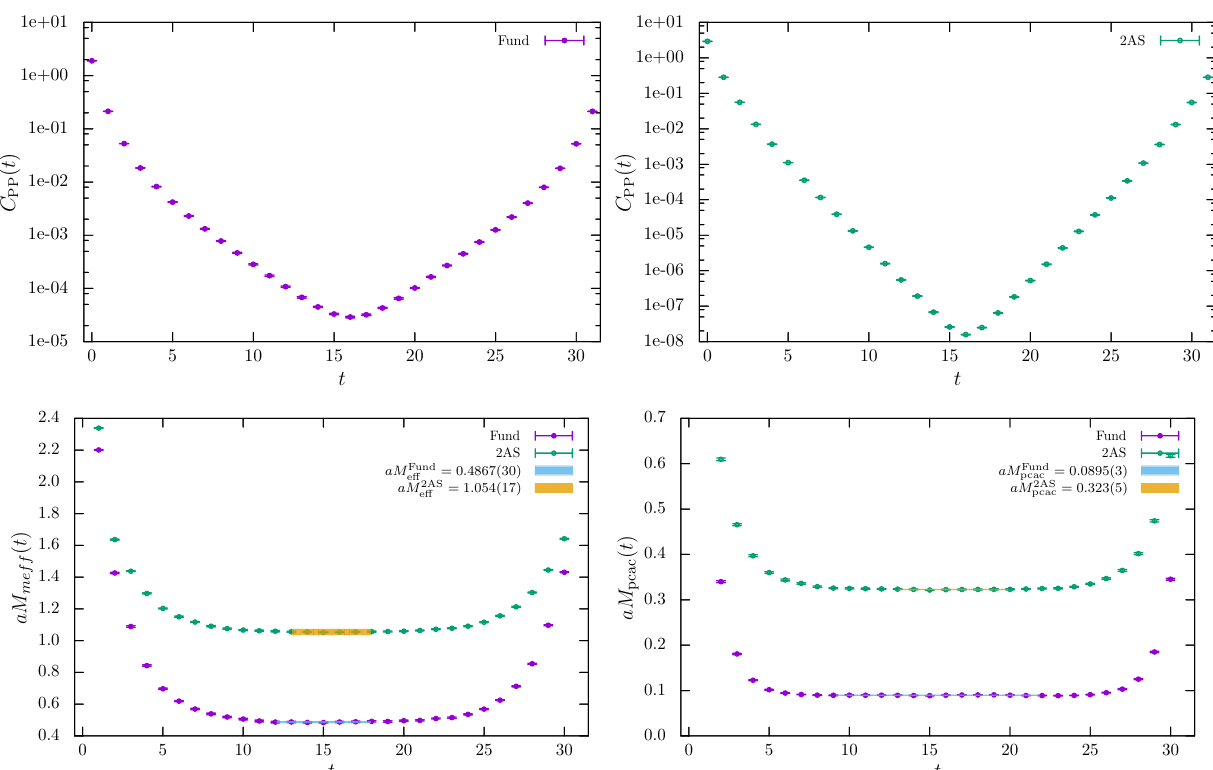
Fig. 6 On the top panels we show an example of the pseudoscalar cor- relators obtained with degenerate bare fermion masses am 4 = am 6 = − 0 . 55, on the bottom left panels the effective masses of “pion-like”